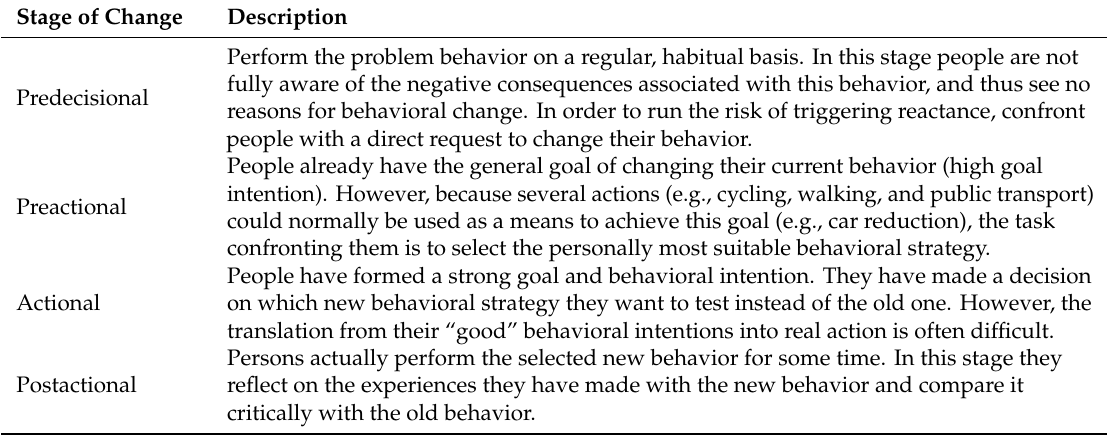
Table 1. Bamberg’s stage model of self-regulated behavioral change